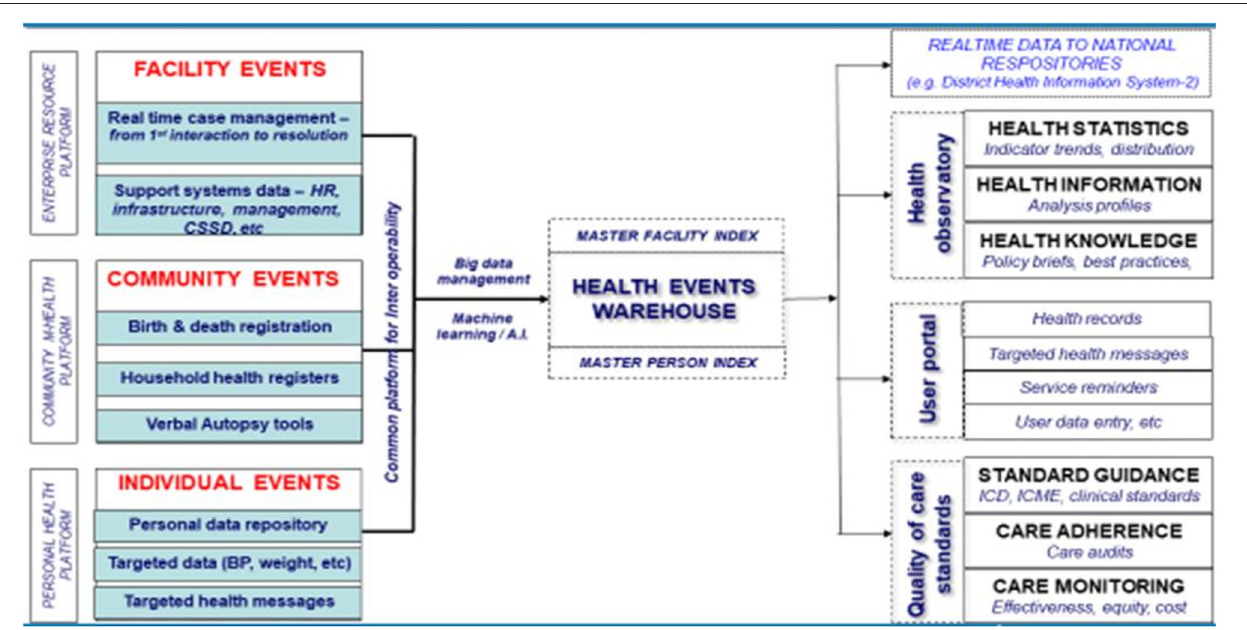
FIGURE 1 | Comprehensive WHOAFRO Digital Health Platform